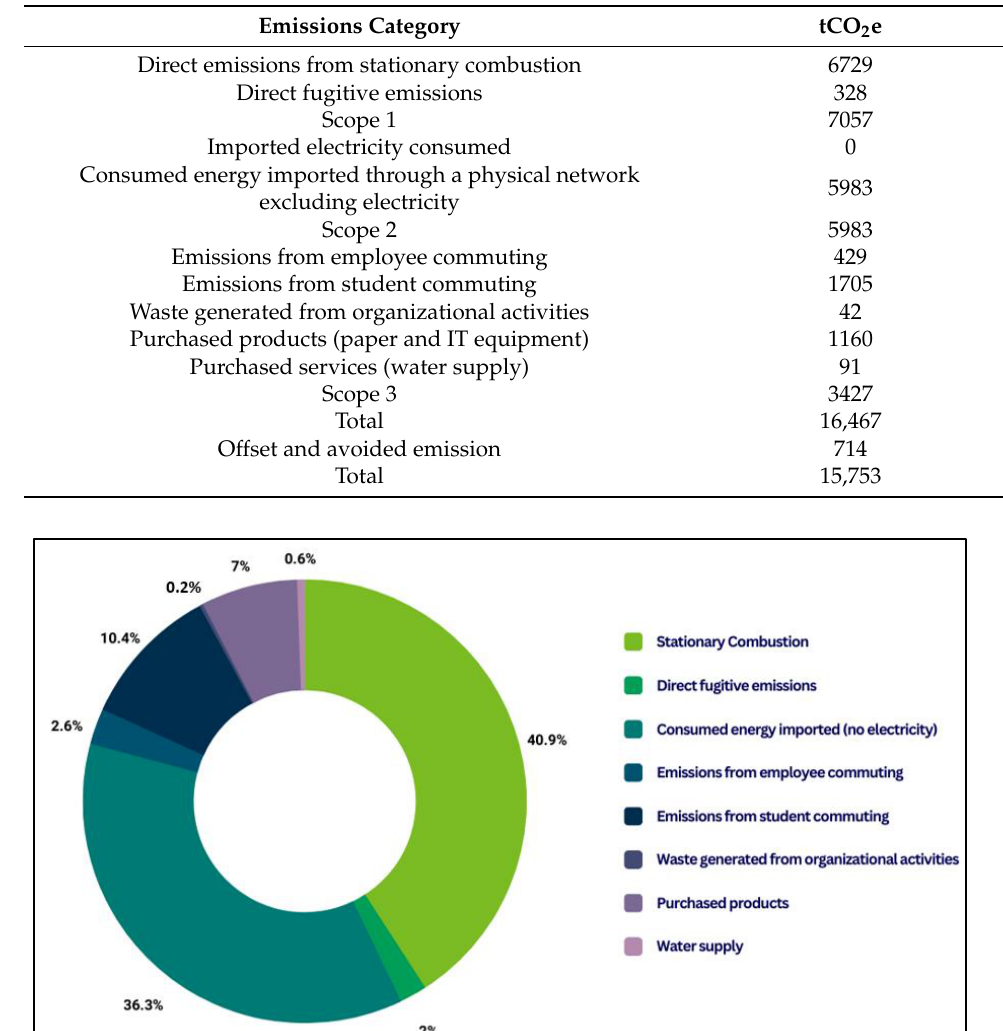
Table 12. Unibo carbon footprint related to 2020.